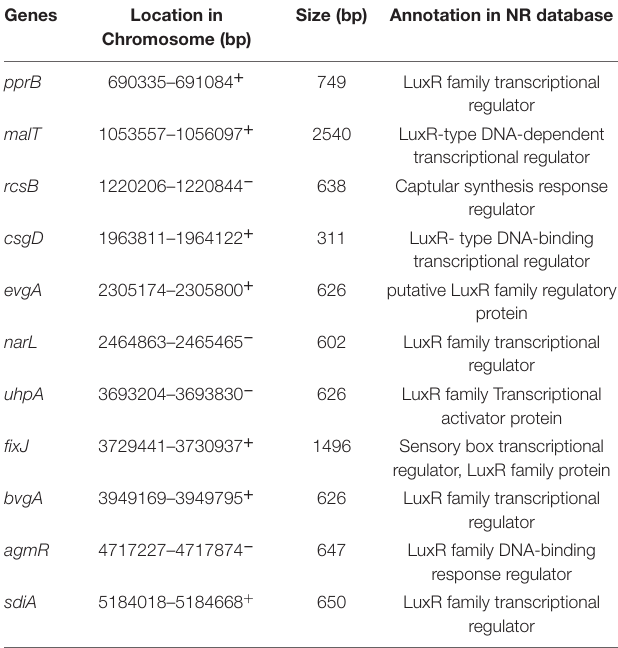
TABLE 2 | Genes encoding predicted LuxR solo type proteins in the genome of Pseudomonas fluorescens PF08. Genes Location in Chromosome